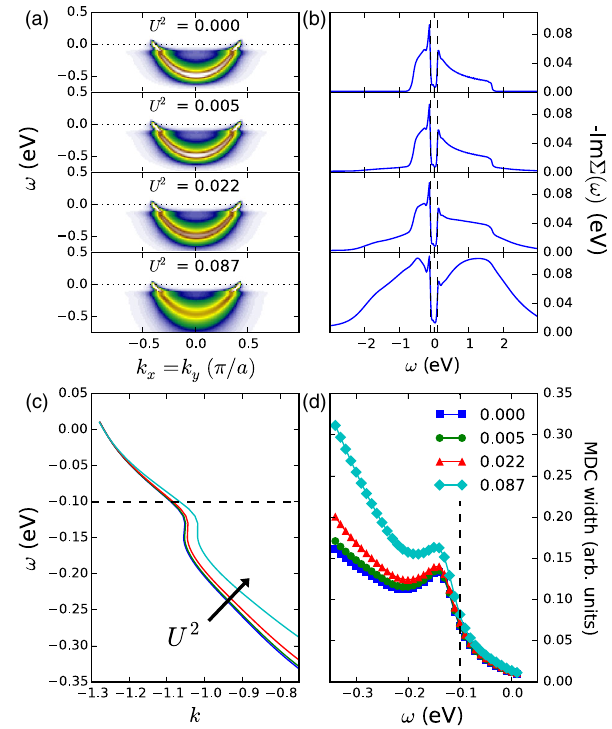
FIG. 7. Effect of combined electron-electron and electron- phonon scattering in equilibrium. (a),(b) Equilibrium ARPES spectra and self-energies ½ − Im Σ ð ω Þ(cid:2) for various Coulomb- scattering strengths U . The phonon-scattering strength is kept constant at g 2 ¼ 0 . 02 eV. (c),(d) Extracted dispersion ϵ ð k Þ and MDC widths from the ARPES